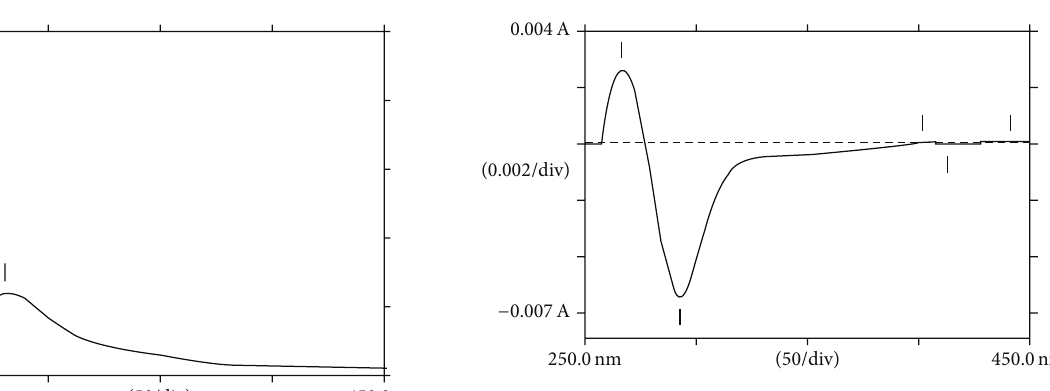
Figure 3: First derivative spectrum of colistin solution (298 nm, 1600 IU/mL).